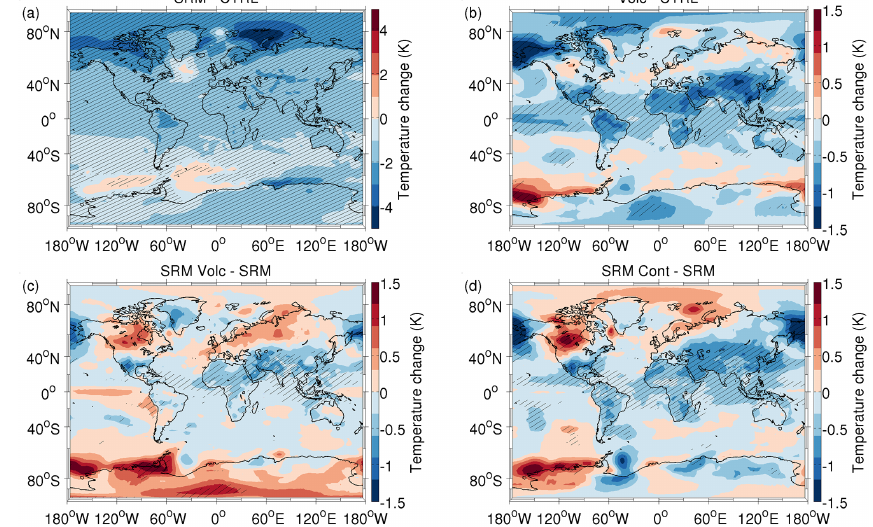
Figure 5. Ensemble mean change in annual mean 2m temperature. (a) 50-year mean temperature change in SRM scenario; 1-year-mean temperature change after the volcanic eruption in (b) Volc, (c) SRM Volc and (d) SRM Cont compared to the pre-eruption climate (CTRL for SRM and Volc, and SRM for SRM Volc and SRM Cont). Hatching indicates a regions where the change of temperature is statistically significant at 95% level. Significance level was estimated using Student’s unpaired t test with a sample of 10 ensemble member means for panels (b–d) and a sample of 50 annual means for panel (a) . Note the different scale in panel (a)